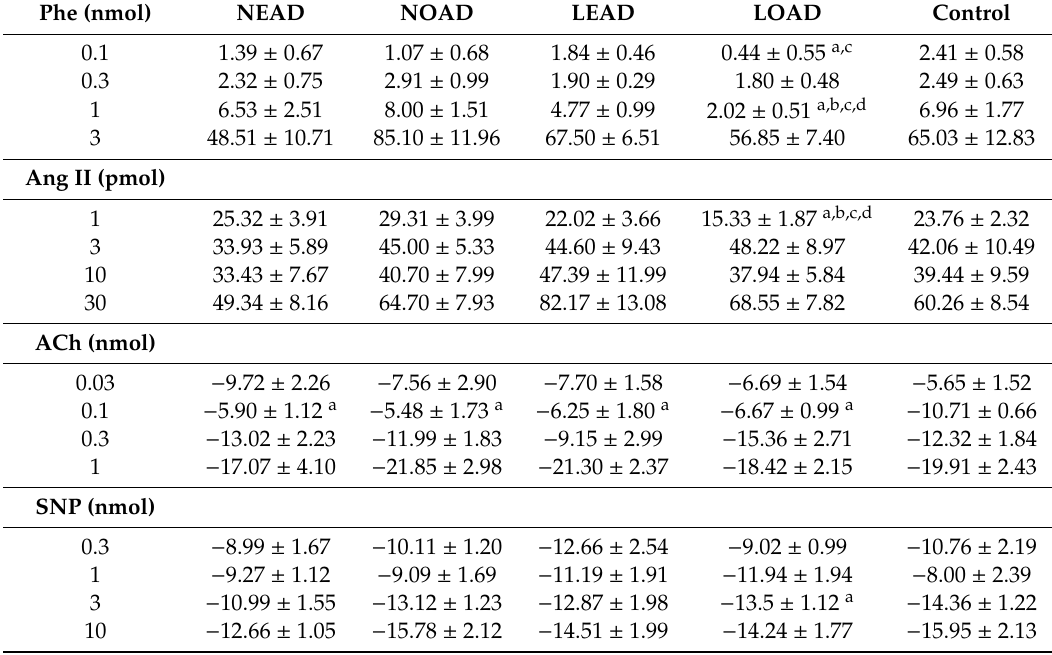
Table 6. Renal vascular reactivity in the various groups over 60 days of treatment. The data are presented as perfusion pressure variation (mmHg) after Phe, Ang II, ACh, and SNP administration.